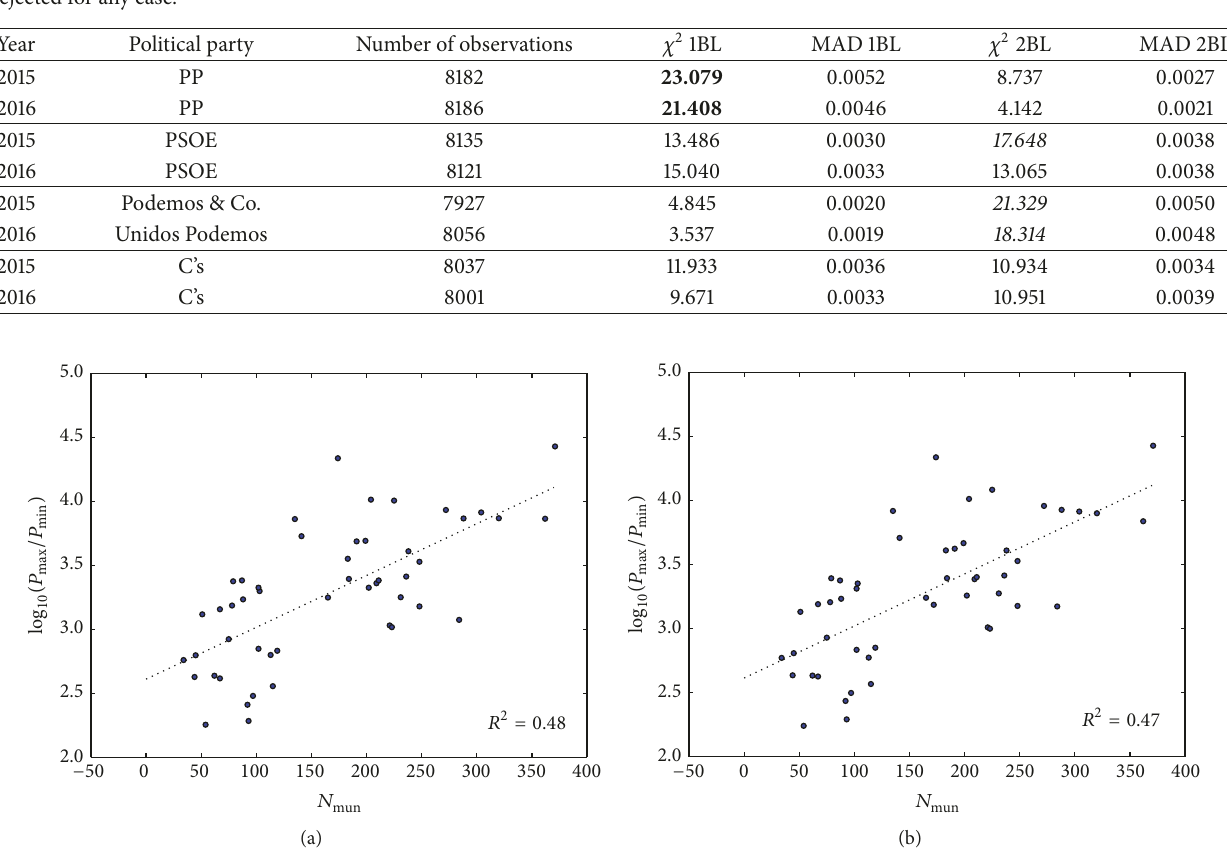
Figure 8: Scatter plot of the number of orders of magnitude spaned by the voting populations of a precinct as a function of the number of municipalities in each precinct, for 2015 (a) and 2016 (b). We find a positive correlation with 𝑅 2 ≈ 0.47 suggesting that the “size” of a precinct in terms of the number of municipalities explains 47% of the variation in the support (in terms of orders of magnitude) of the number of votes (the larger the number of municipalities is, the more likely the number of votes takes values from a larger number of orders of magnitude). The coefficient of 0.004 indicates that, on average, when we move from a precinct with 𝑥 municipalities to one with 𝑥 + 100 , the ratio of the biggest population to the smallest is 2.5 times